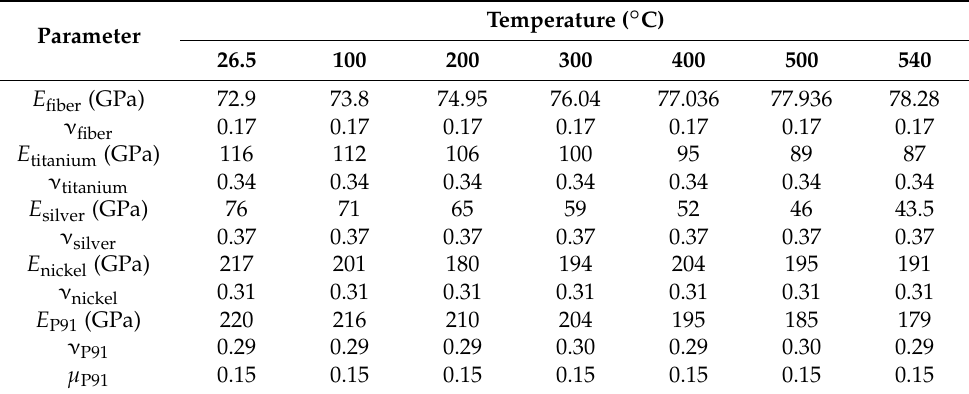
Table 1. Material parameters for three-dimensional (3-D) finite element (FE) analysis